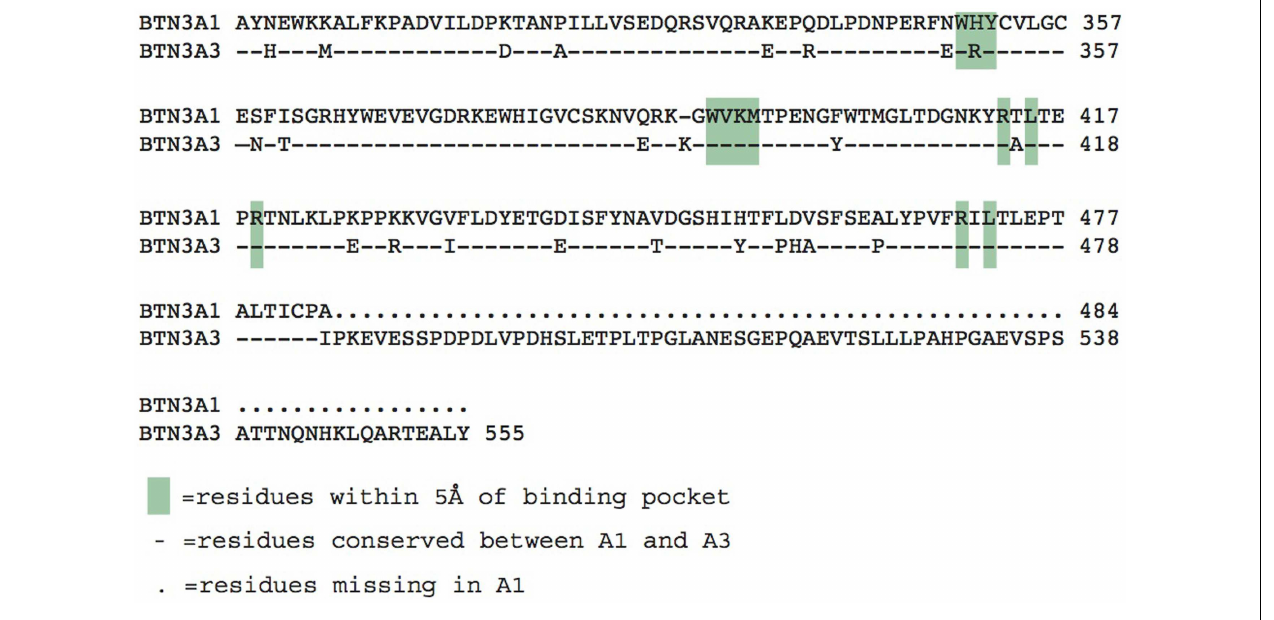
FIGURE 5 |Alignment of the intracellular B30.2 domains from BTN3A1 and BTN3A3 . Amino acids are shown in the single letter designations, BTN3A1 is the consensus. “-” indicates positions of identity with BTN3A1,